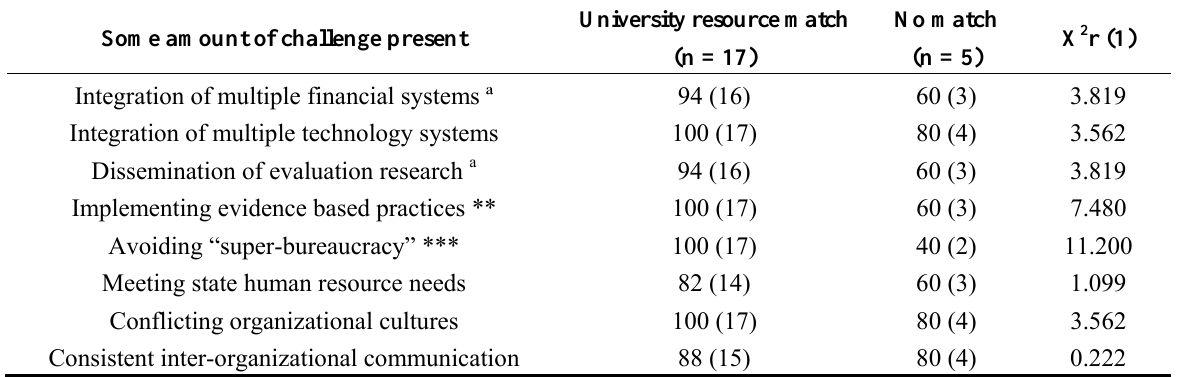
Table 5. Prevalence (%) of agencies reporting some amount of challenge (strongly agree or agree) in partnership by requirement to match with university resources ( N =